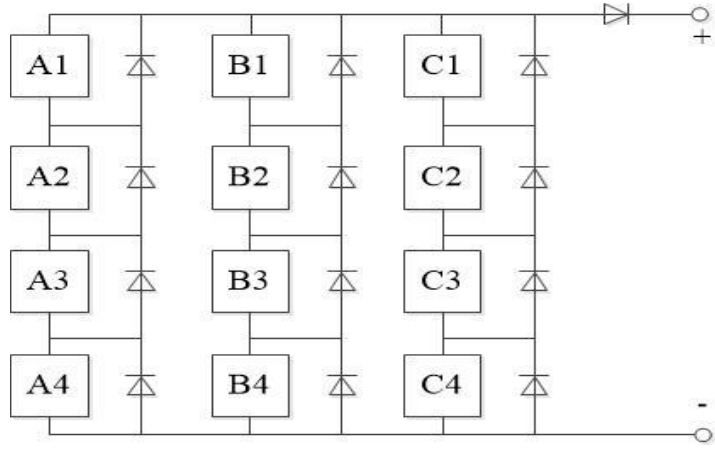
Figure 4. Structure of 4 × 3 PV array.